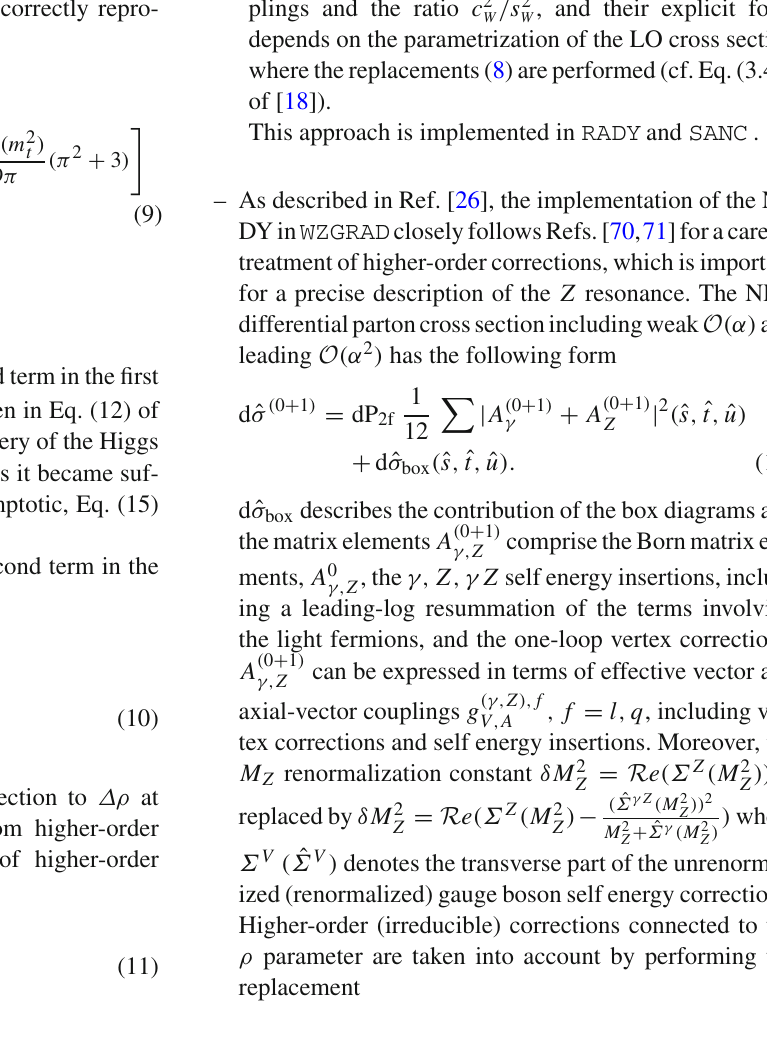
Fig. 27 Comparison of RADY NLO EW predictions when using different schemes for treating the Z resonance. The plots show the inverse mass and momentum distribution of the final-state lepton in in the LO expression for the NC DY cross section. As was argued in Refs. [62,63], this approach correctly repro- duces terms up to O (Δρ 2 )